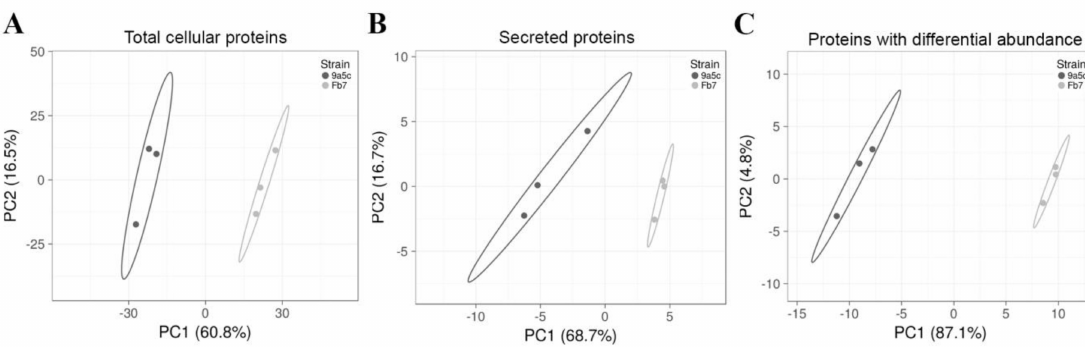
Figure 2. Clustering of samples used in proteomics by principal component analysis (PCA). E ff ect on principal components and tightness of clusters is seen when ( A ) all 1011 detected proteins in the total cellular extracts are used in the clustering or ( B ) when 18 proteins detected in the secretome are used or ( C ) when the 128 proteins with di ff erential abundance are used, forming tighter clusters. Samples from strain 9a5c consistently clustered on the left side of the plots, while those from strain Fb7 on the right side of the plots. Prediction ellipses are such that with probability 0.95, a new observation from the same group will fall inside the